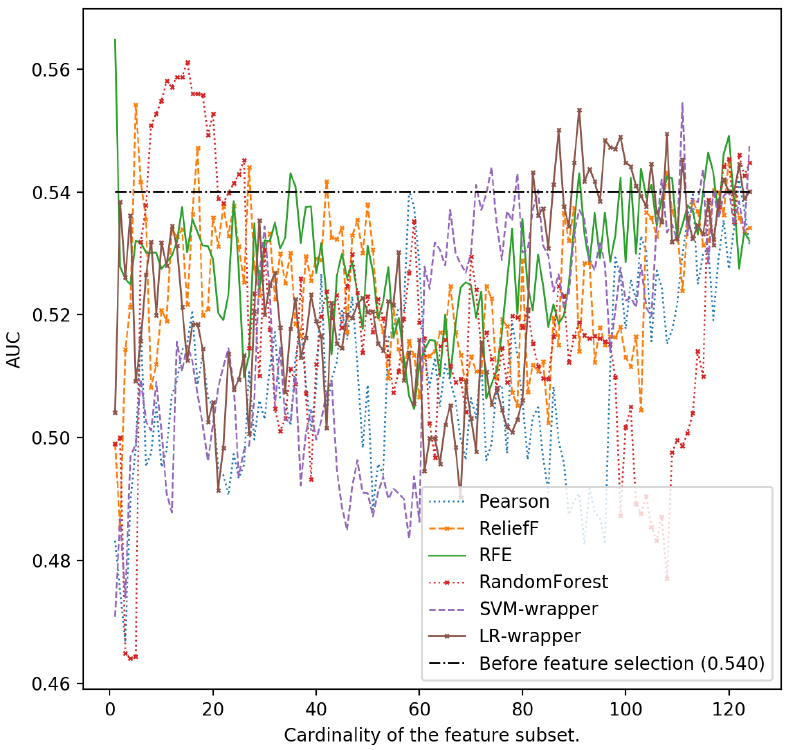
Figure 1. Area under the curve using the complete data set without reducing features and different cardinality of the subset of features for different classifiers: